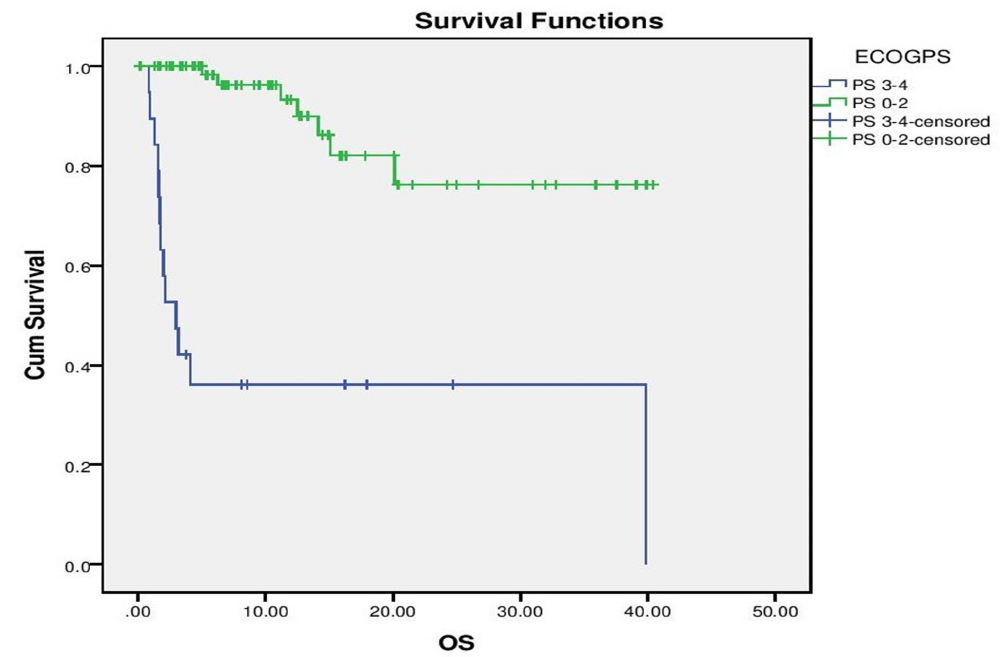
S1 Table. “ Initial treatment distribution ”